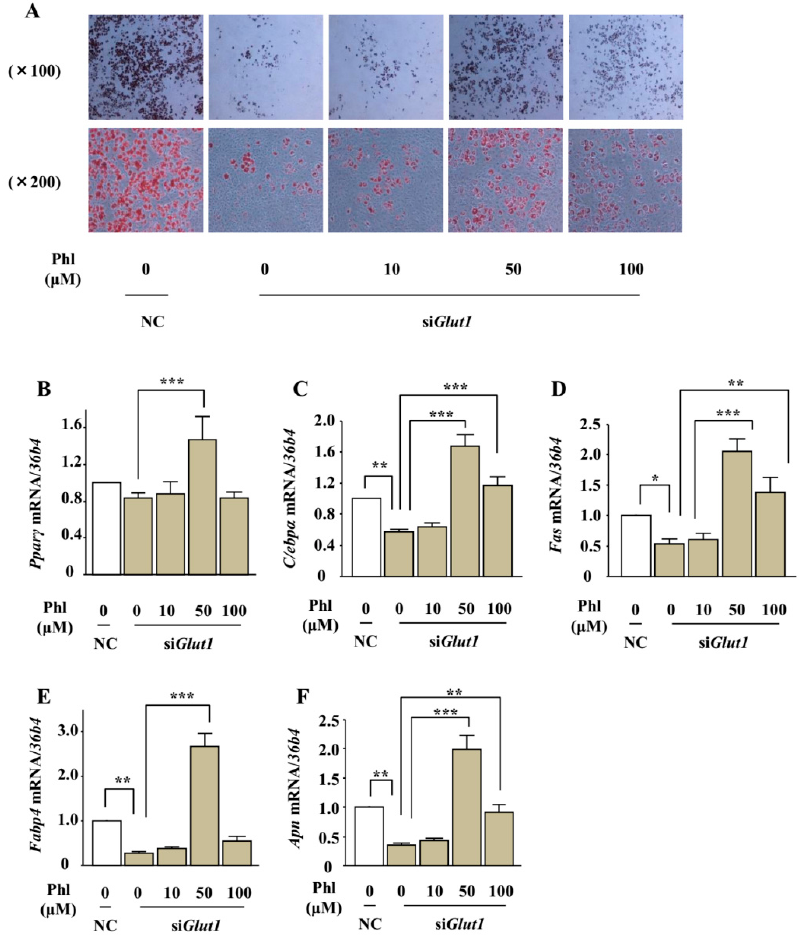
Figure 8. The effect of phloretin on adipocyte differentiation in Glut1 knocked-down ST2 cells. ( A ) After transfection with control or Glut1 siRNA, the cells were incubated in adipogenic medium containing phloretin 0–100 µ M, and oil red O staining was performed at day 8. ( B – F ) After transfection with control or Glut1 siRNA, the cells were incubated in adipogenic medium containing phloretin 0–100 µ M for 4 days. The mRNA expression of adipogenic differentiation markers ( Ppar γ , C/ebp α , Fas , Fabp4 , and Apn ) was examined by real-time PCR. The results are expressed as mean ± SE ( n ≥ 4); * p < 0.05, ** p < 0.01, *** p < 0.001. NC: negative control, Phl: phloretin.